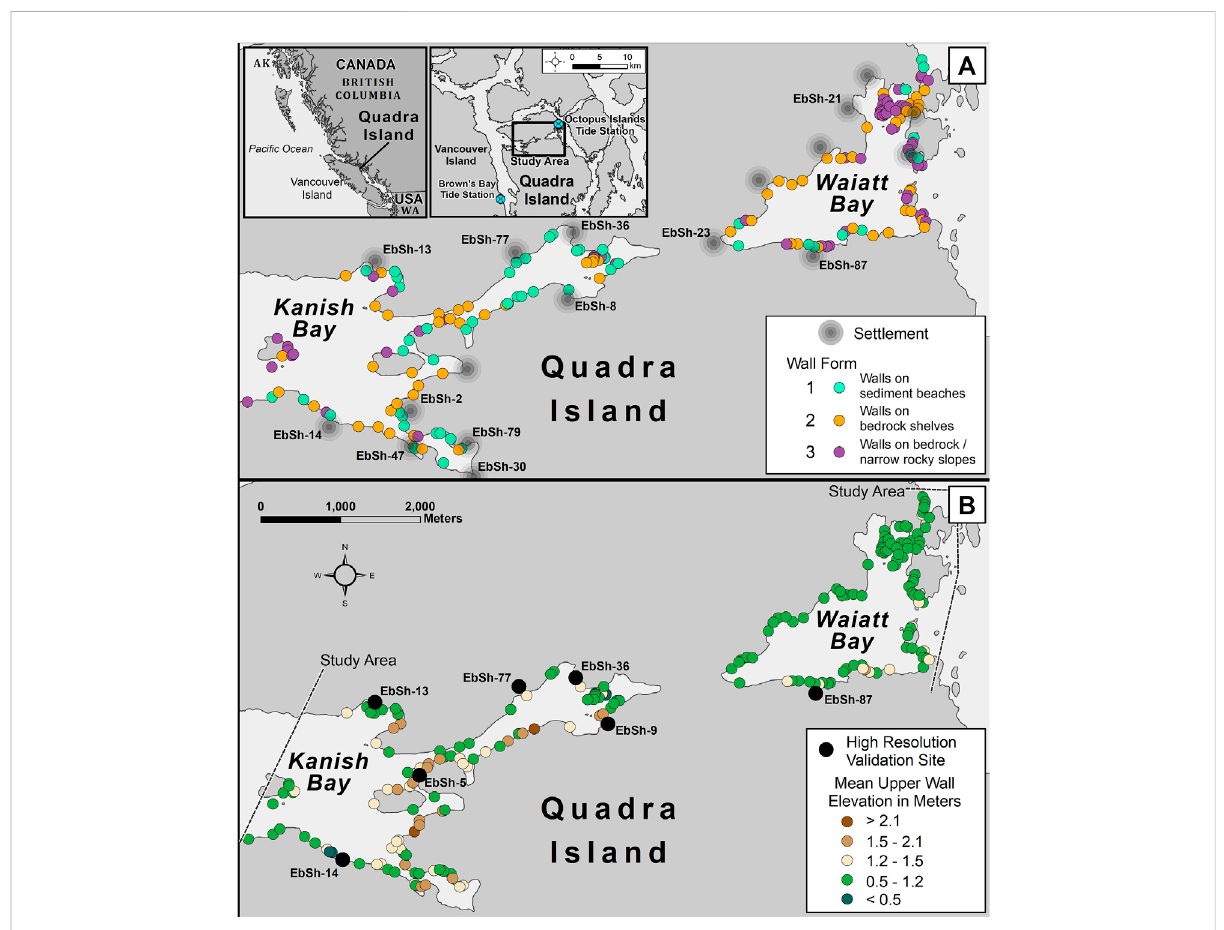
FIGURE 1 Clamgardens arefoundthroughoutthePaci fi cNorthwest coast,from Alaskasouthto northern Washington State (A, leftinset). Someareas like Kanish and Waiatt Bays on northern Quadra Island, British Columbia, have exceptionally high densities of clam garden features along the foreshore (A) . The three forms of gardens (see text for further explanation) are interspersed with many archaeological settlement sites, re fl ecting a densely occupied landscape (Radiocarbon dated settlements used in this study are designated with their site number.) (B) The tops of the clam garden wallsareatdifferenttidalheights(metersabovechartdatum(LowerLowWaterLargeTide[LLWLT])thatcanbeusedtoinferrelativeage.Locationsof high resolution validation sites are shown in black dots with associated archaeological site